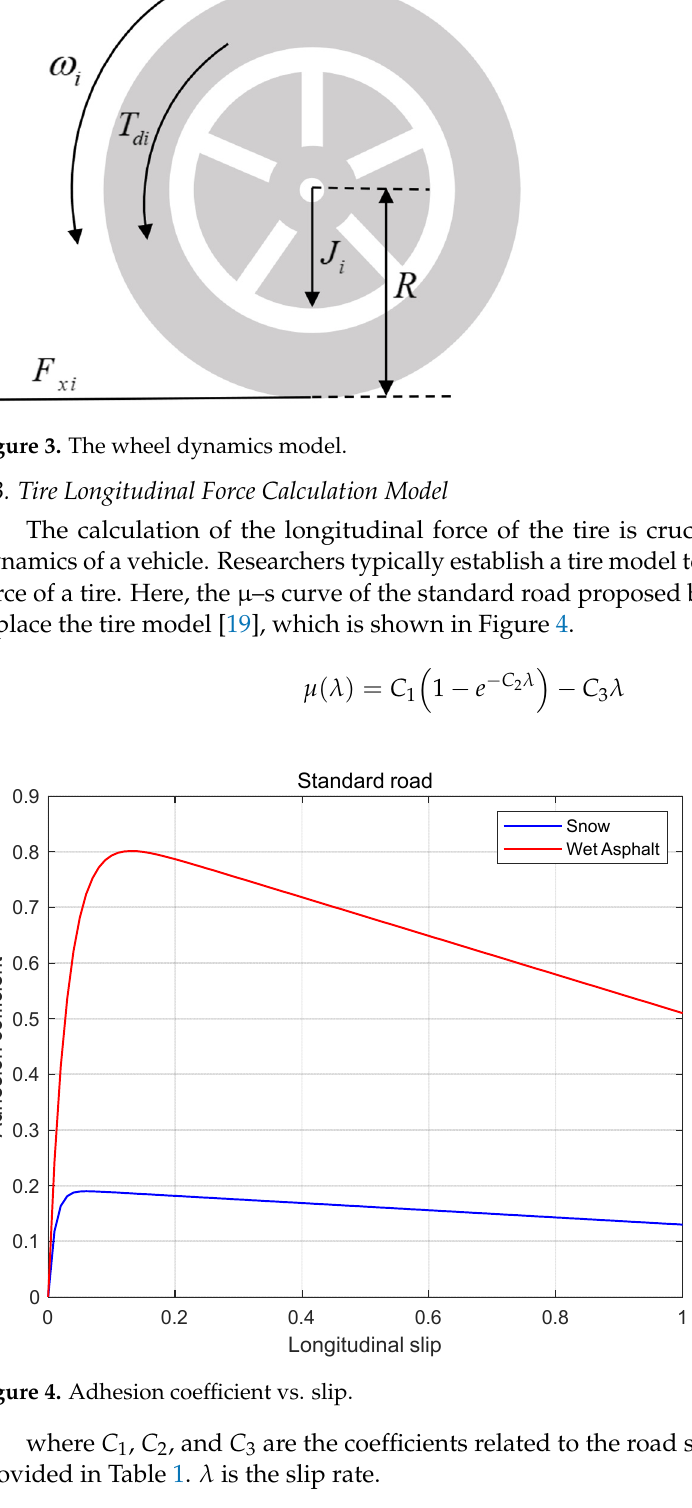
Table 1. The relevant parameters of a standard road. Road